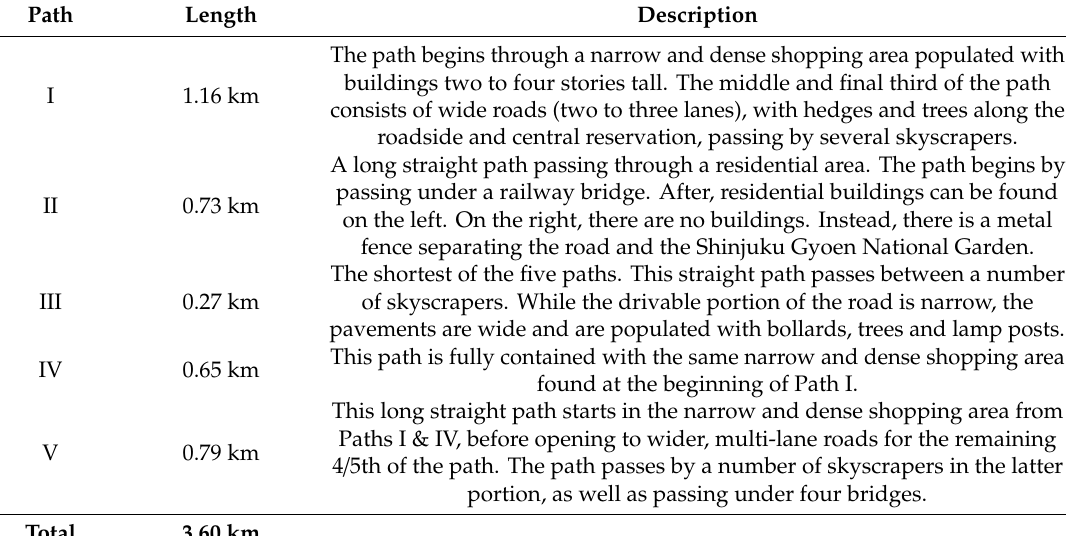
Figure 6. Five experiment paths (I, II, III, IV, V) in Shinjuku, Tokyo, Japan, as viewed in Google Earth. Table 2. Summary of all paths.